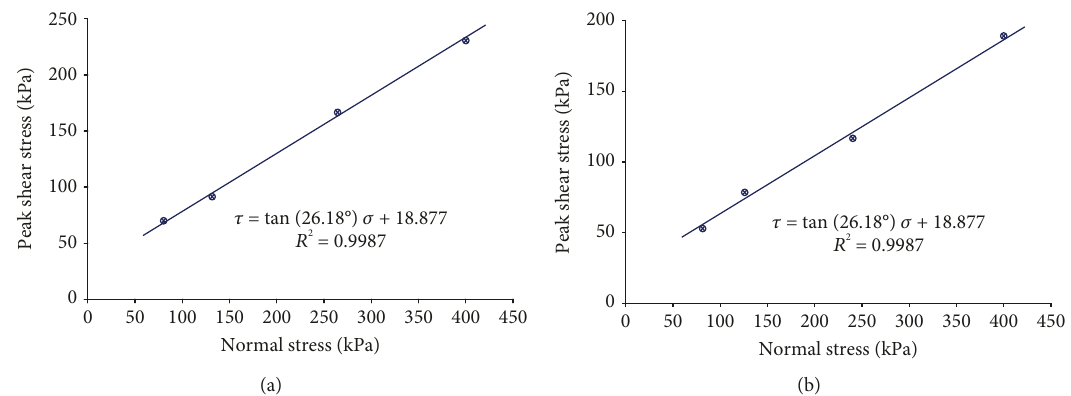
Figure 8: Graph showing the peak and residual strength parameters.